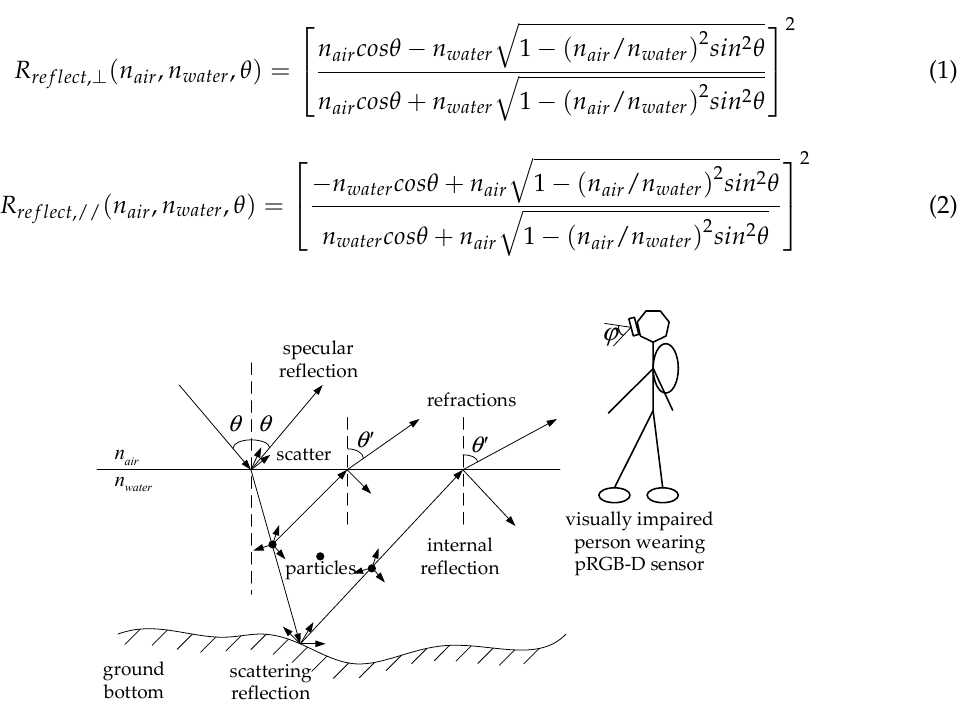
Figure 2. The light reflection and refraction for water hazards with particles and ground bottom.